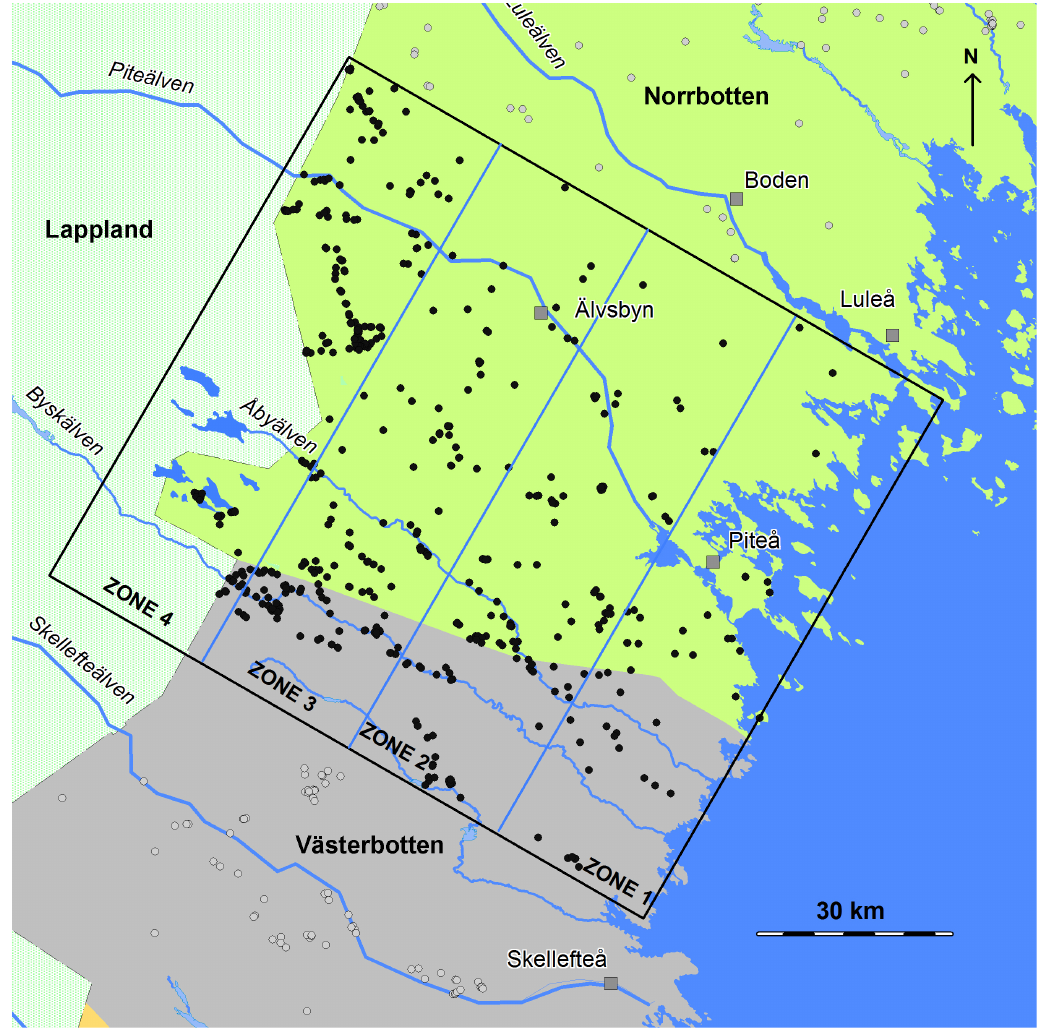
Figure 3. Study area divided into four rectangular zones, i.e. 27 x 94 km in size. Dark dots mark hearth